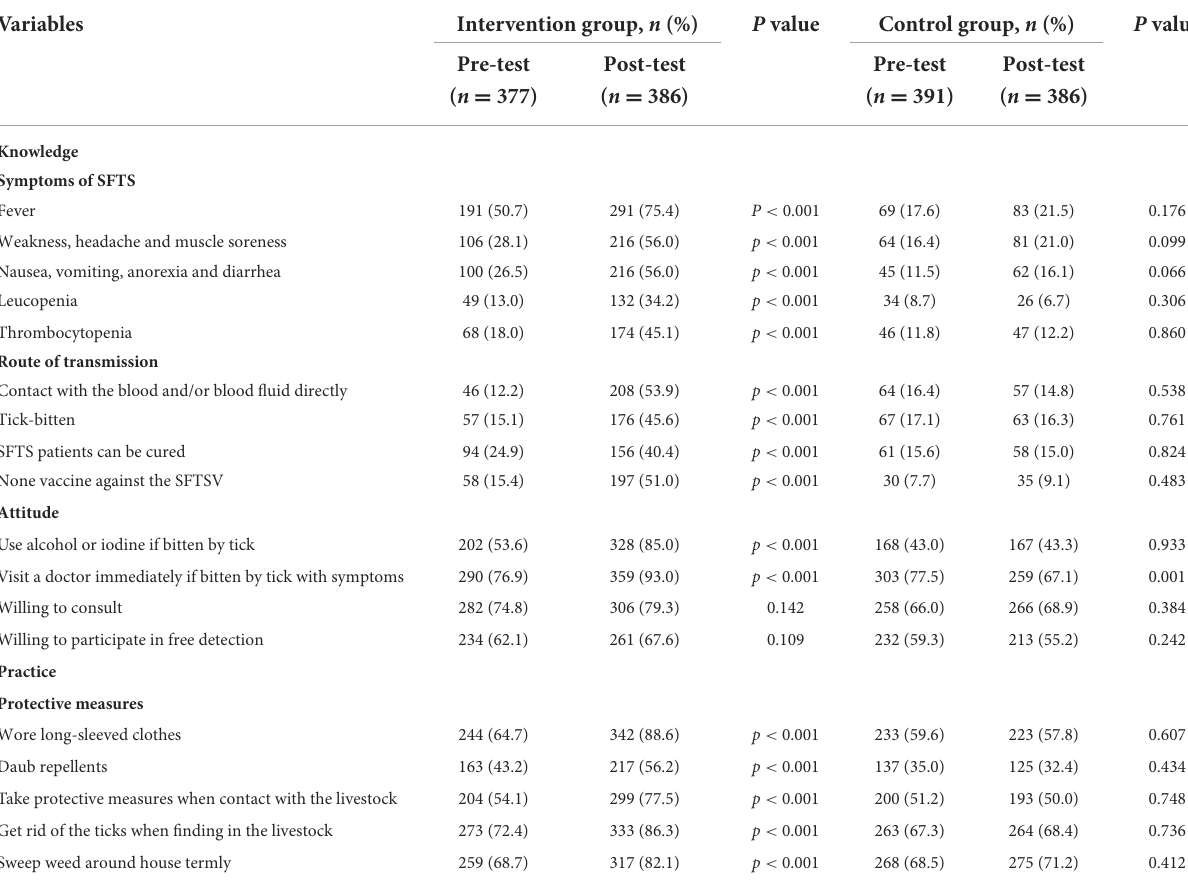
TABLE 2 Responses on SFTS of the study